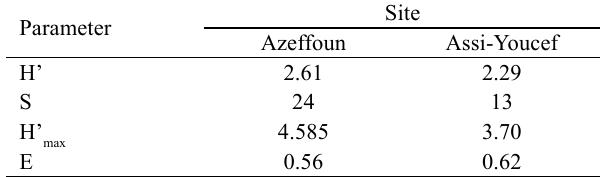
Table 3. Shannon-Weaver (H’) and equitability (E) indices for the two study sites.